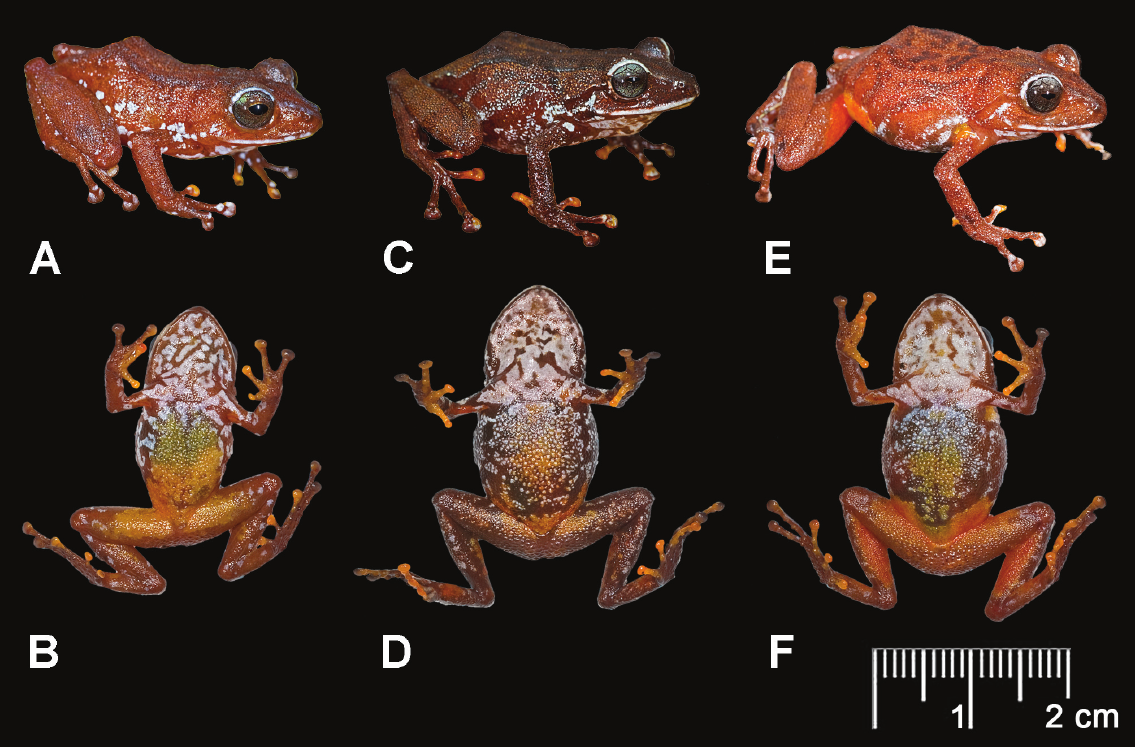
Fig. 2. Pristimantis jamescameroni sp. nov. Intraspecific variation in dorsal and ventral colour pattern in living specimens. A . Dorsolateral view of the ♂ holotype (IRSNB 4160). B . Ventral view of the same specimen. C . Dorsolateral view of a ♀ paratype (IRSNB 4163). D . Ventral view of the same